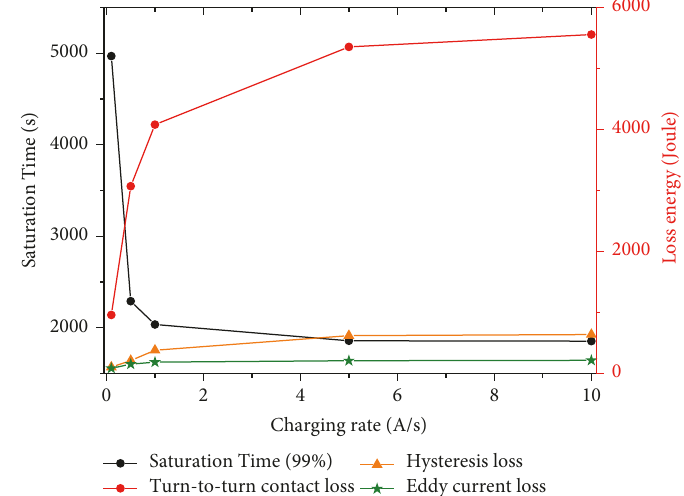
Figure 9: Magnetic field saturation time and losses vary with charging